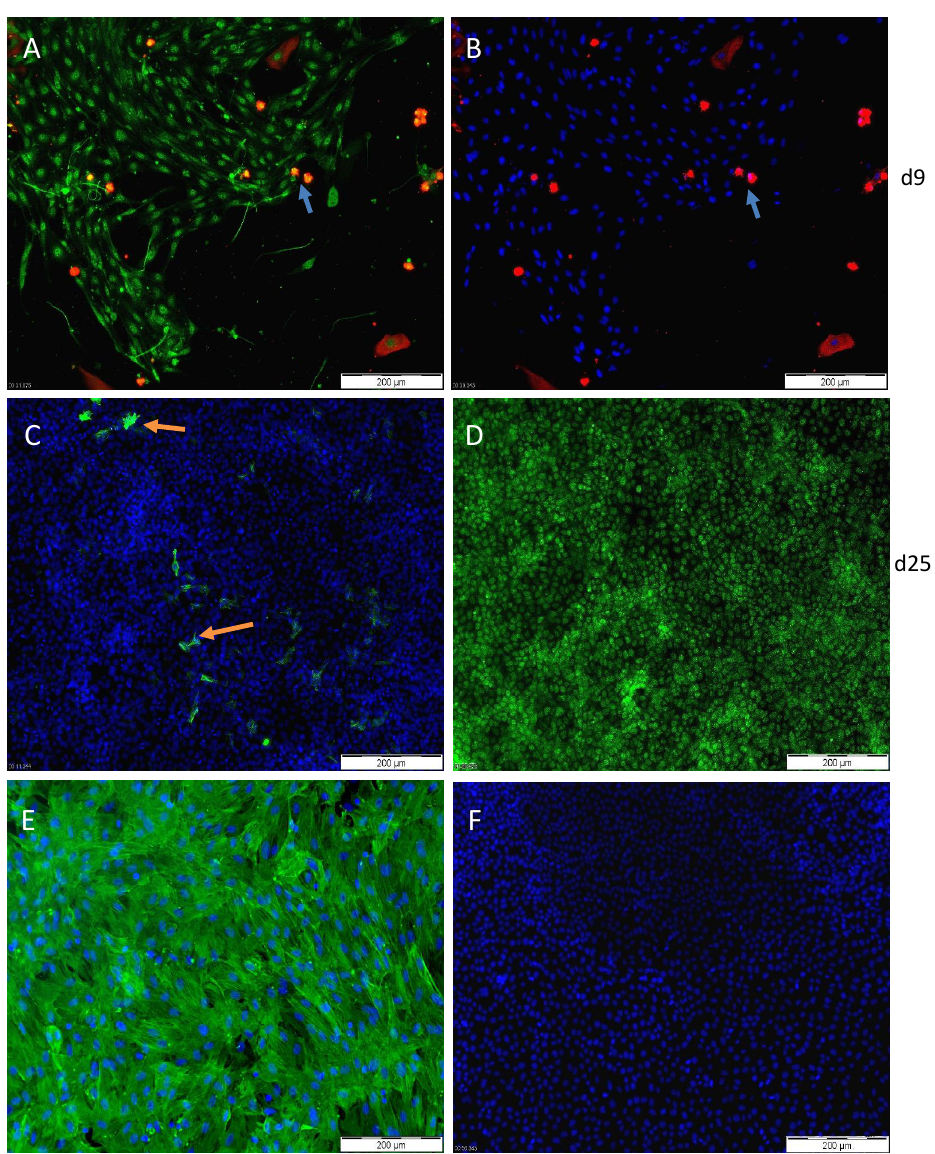
Figure 4. PASC1 were cultivated in complete CM for 9 ( A , B ), and 25 days ( C , D ), and primary PCs for 18 days ( E ) then stained with antibodies against SOX9 ( A , D , green) and ASMA ( A , B , red, C , E green). At day 9 (d9), PASC1 positive for SOX9 (green) are shown in addition to very few contaminating ASMA-positive PCs (red) ( A , B , arrows indicating few PCs); the round phenotype indicates that the PCs are dying due to the complete CM, as published [14,15]. At day 25 (d25), the purity of SCs is increased, with only very few ASMA-positive PCs ( C , arrows, green) with ~99% of the cells positive for SOX9 ( D , green). Primary PCs stained with ASMA were used as a positive control ( E ); in ( F ), the negative control without any primary antibody is shown. The nuclei were stained with DAPI